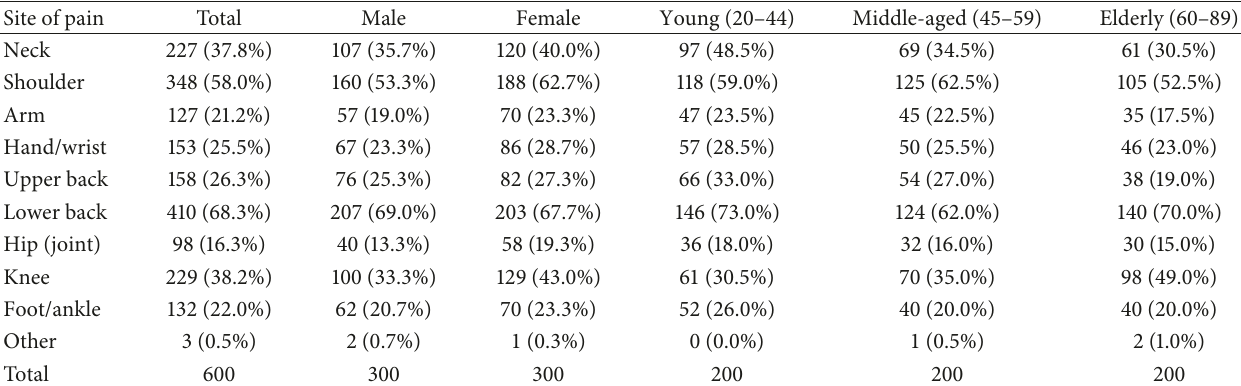
Table 2: Patient survey: pain site by gender and age group (multiple responses